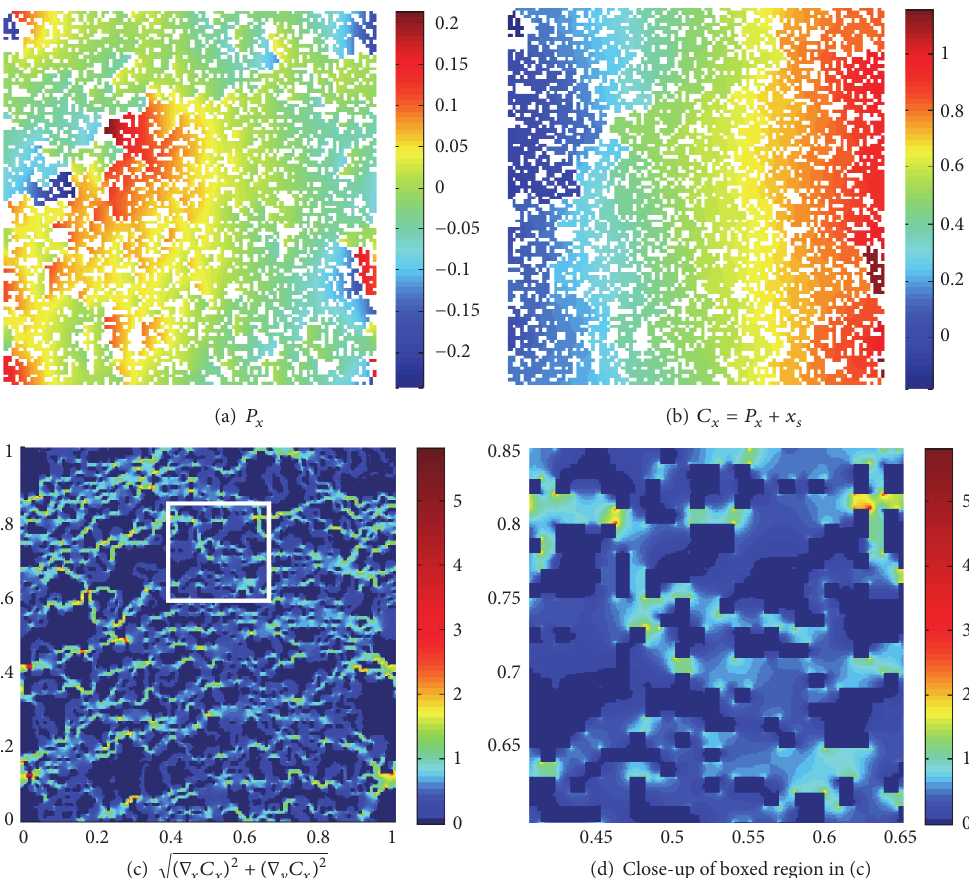
Figure 21: Fields for geometry of randomly distributed squares, 𝜙 = 0.7 : (a) solution to the homogenization problem, (b) concentration field transformed from 𝑃 𝑘 (assuming concentration gradient across unit cell is one), and (c, d) magnitude of concentration gradient (diffusion